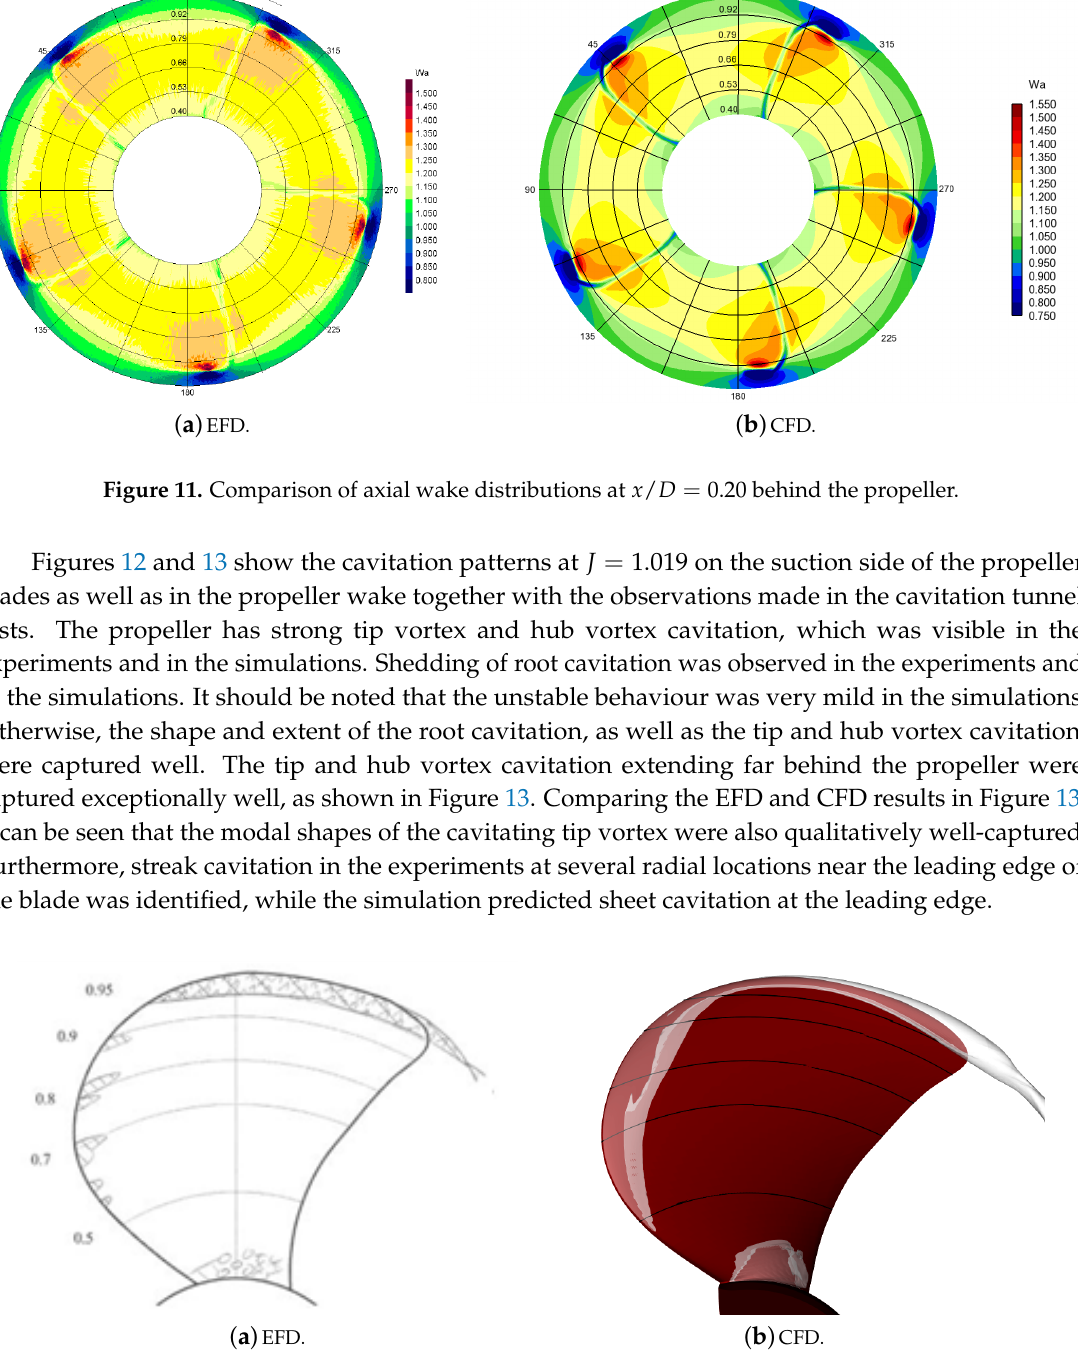
Figure 12. Comparison of the cavitation patterns near the blade surfaces with the cavitation sketches according to observations made in the experiments, cf. Ref.